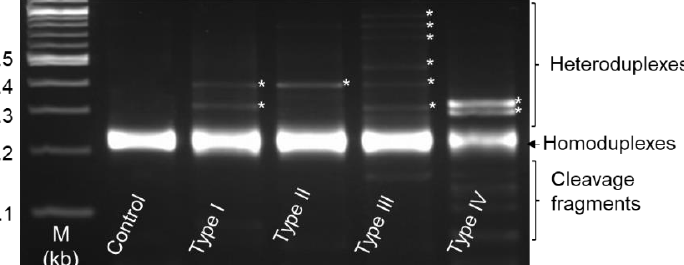
Figure 8. Heteroduplex detection by PCR followed by gel electrophoresis. Multiple homoduplex and heteroduplex bands (asterisks) were present in PCR products from each classified type (phenotypic classes within slc24a5 TALEN-injected embryos), whereas a single sharp band was present for the control embryo (no TALEN injection). The molecular size of the marker (50 base pair DNA ladder) is shown on the left. M: molecular marker; kb: kilobase.